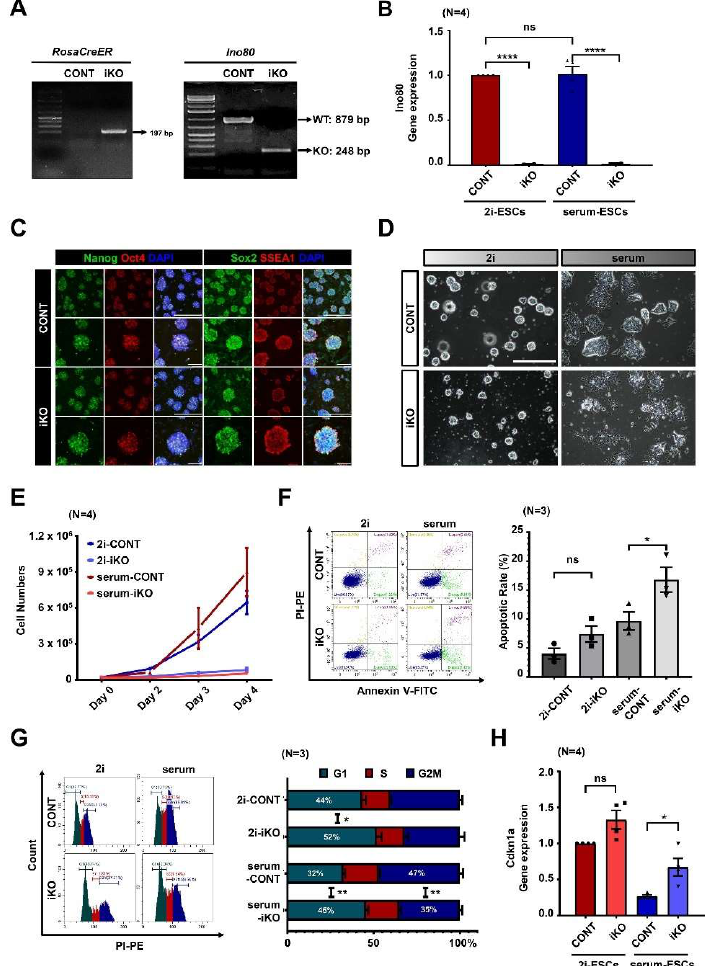
Figure 1. Ino80 loss leads to extension of G1-phase and apoptosis in embryonic stem cells cultured in serum-media (serum–ESCs). ( A ) Result of PCR genotyping. ROSA26-CreER allele was detected only in Ino80 iKO ESCs. After treating the ESCs with 4-OHTM, homozygous conditional allele was detected in CONT ESCs and Ino80 knockout allele was detected in Ino80 iKO ESCs. Ino80 iKO ESCs, inducible Ino80 knockout ESCs. 4-OHTM, 4-hydroxytamoxifen. ESCs, embryonic stem cells. CONT ESCs, control ESCs. ( B ) Expression levels of Ino80 using mIno80 primer (detecting exon 6) in both CONT and Ino80 iKO ESCs maintained in 2i- or serum-media was examined by qRT-PCR (N = 4). mIno80, mouse Ino80. ( C ) Immunofluorescence analysis of pluripotent markers (Nanog, Sox2, and SSEA1) in CONT and Ino80 iKO ESCs cultured in 2i-media containing 4-OHTM. Scale bar, 200 μm. ( D ) Representative images of CONT and Ino80 iKO ESCs cultured in either the 2i- or serum-media. ESCs were treated with 4-OHTM for 3 days and adapted to 2i- and serum-media for at least 2 days. Scale bar, 200 μm. ( E ) Cell proliferation assay. Cell numbers of the CONT and Ino80 iKO ESCs were counted at days 2, 3, and 4 after seeding 20,000 ESCs cultured in either 2i- or serum-media (N = 4). ( F ) Representative images of apoptosis analysis by flow cytometry and quantification. Annexin V(+) cells were measured in the CONT and Ino80 iKO ESCs. The difference in apoptosis rates between CONT and Ino80 iKO ESCs cultured in 2i-media is 3.40% on average, and in serum-media is 7.14% on average. p -value was calculated by one-way ANOVA test (N = 3). ( G ) Representative histograms of cell cycle and quantification. Percentages of G1, S, and G2/M phases of the CONT and Ino80 iKO ESCs measured by flow cytometry were plotted (N = 3). ( H ) Relative expression of Cdkn1a, by using qRT-PCR in both 2i-media and serum-media, the expression levels of Cdkn1a in CONT and Ino80 iKO ESCs were investigated (N = 4). Statistical significance was determined at a p -value lower than 0.05 (*), 0.01 (**) or 0.0001